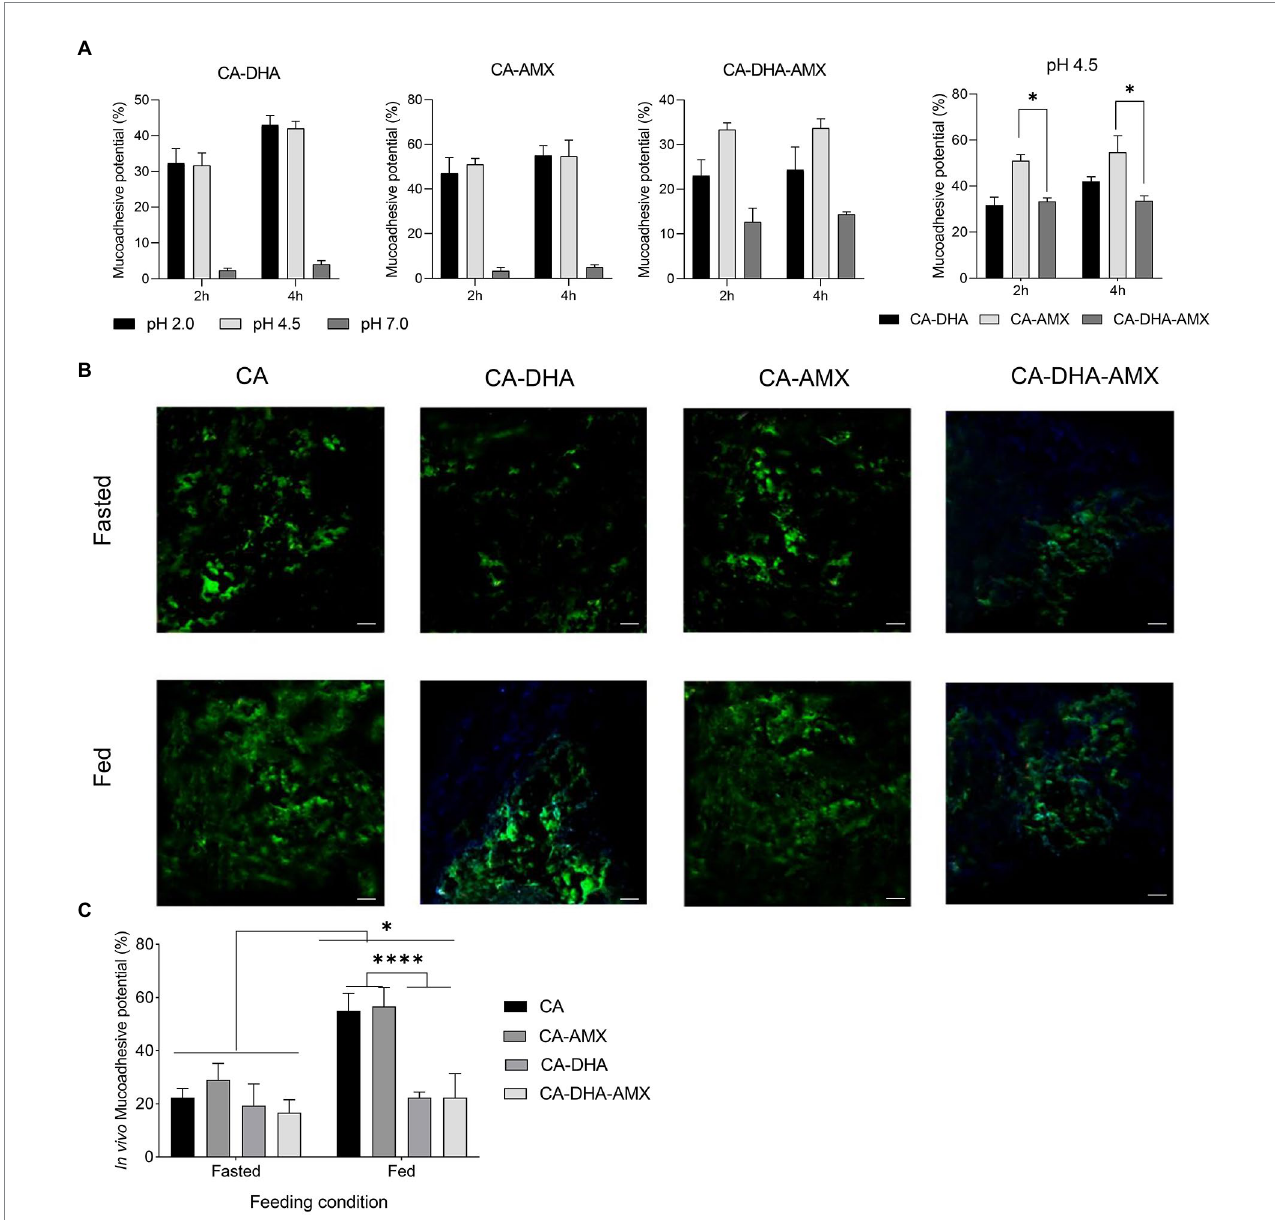
FIGURE 5 The mucoadhesion potential of composite NPs. (A) The in vitro assessment of mucoadhesive potential. Results of the unloaded NPs were similar to CA- AMX (data not shown). (B) In vivo mucoadhesive activity was evaluated by fluorescence microscopy under two distinct diet conditions; fasted (2 h before feeding) and fed (2 h after feeding, scale bar 500 μ M). (C) The in vivo mucoadhesive activity was performed under two feeding conditions, fasting and feeding. Data are presented as mean ± SEM ( n =